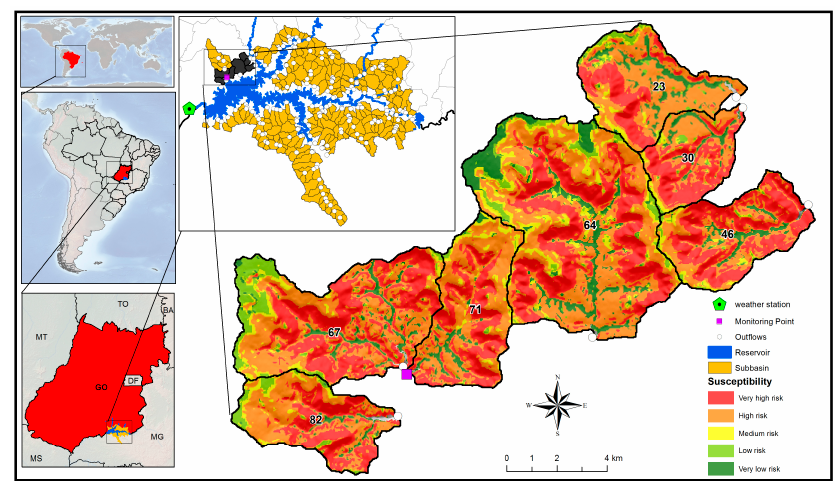
Figure 2. Itumbiara hydroelectric power plant (HPP)—Brazil: left hand figures (top to bottom): Brazil, Goias State in Brazil, location of Itumbiara HPP in Goias Sate; right hand figures (top to bottom): Map of Itumbiara HPP showing sub-basins; zoomed detail of the study area divided into 7 sub-basins (23, 30, 46, 64, 67, 71, and 82), showing laminar erosion susceptibility.